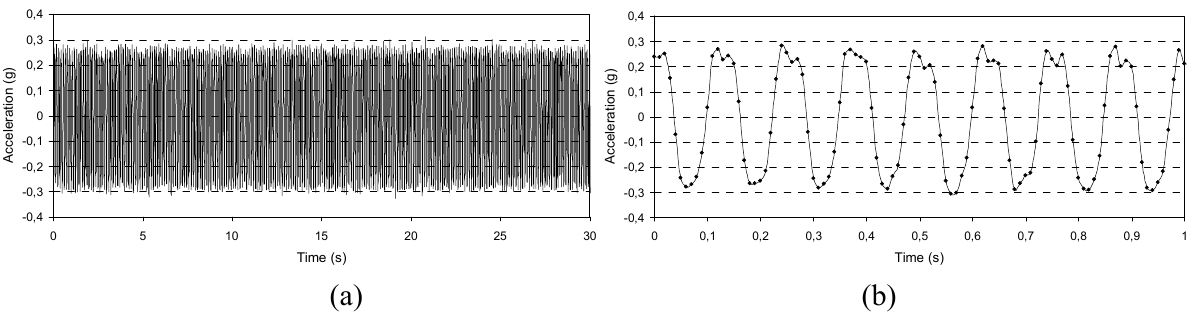
Figure 10. Signal stability after dynamic excitation: 0.3 g amplitude, 8 Hz frequency, x-axis; whole acquisition (a) and detail of the wave form (b).